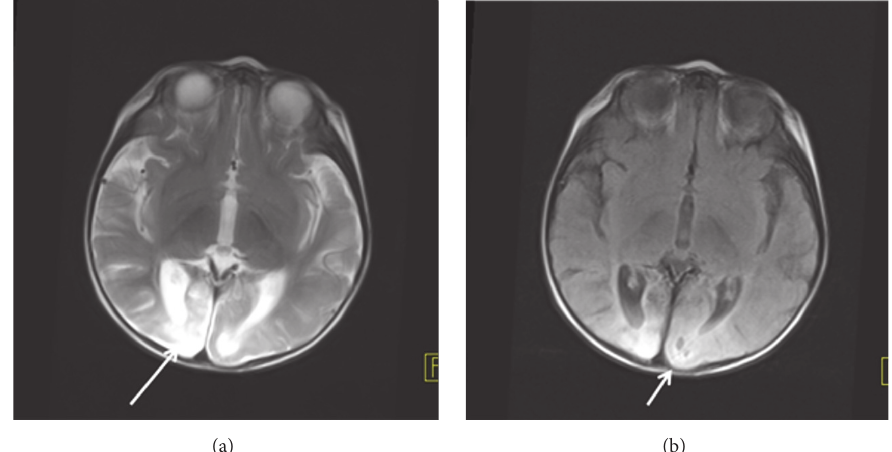
Figure 2: On brain Magnetic Resonance (MR) images, both visual cortices were hyperintense (a) (long arrow) on T2-weighted and flair weighted (b) (arrow)